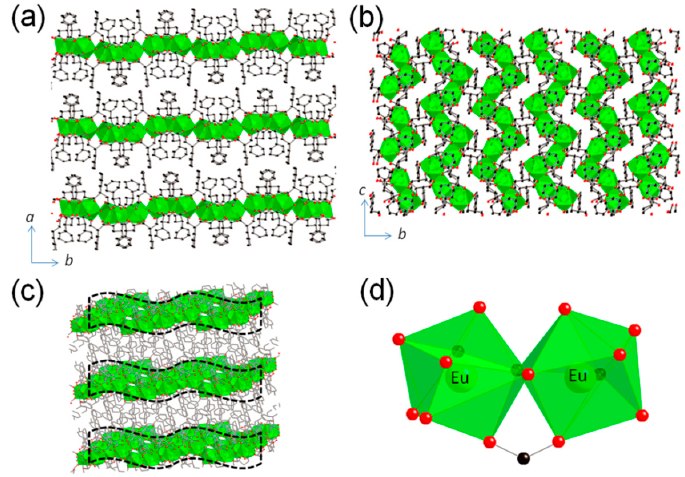
Figure 5. Projection on the ab and bc planes of Eu-PSA ( a , b ), and the development of the layered structure ( c ). The lanthanide environment of two adjacent metallic centers ( d ). Hydrogen atoms were omitted for clarity.